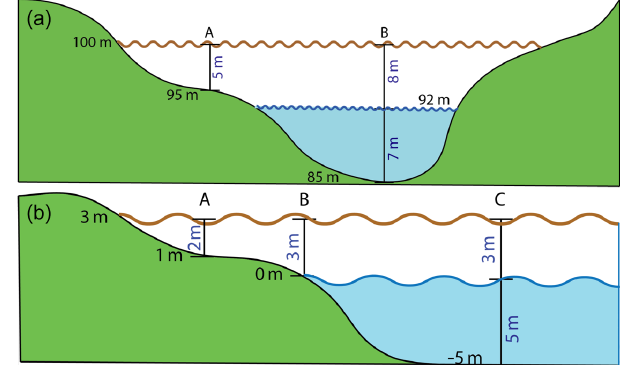
Figure 1. Theoretical floodplain (a) and coastal (b) cross sec- tions illustrating a FwDET floodwater depth calculation approach. The elevation (a.m.s.l.; black numbers) of the floodwater boundary (100m at the top and 3m in the bottom) are used to calculate water depth (blue numbers) for each grid cell within the flooded domain (point A). In riverine flooding (a) underestimation of water depth is expected over the river (point B) as DEMs typically capture the wa- ter surface elevation. In coastal flooding (bottom panel) the seaward flood boundary can be at the coastline (point B) or over the ocean (point C) and cannot be used to estimate floodwater depth (eleva- tion ≤ 0). In FwDET v2.0 these boundary locations are excluded, which means that only the inland flood boundary is